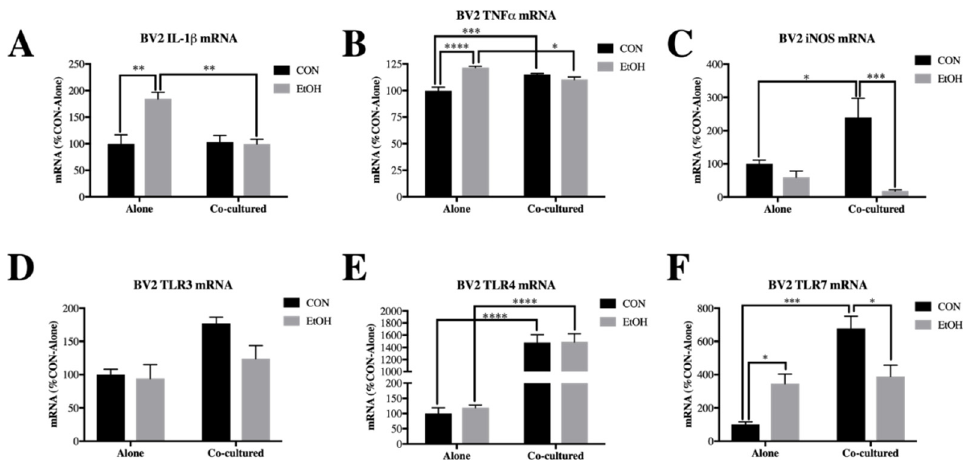
Figure 2. Co-culture alters ethanol-induced cytokines and Toll-like receptors (TLRs) in BV2 microglia. BV2 microglia were treated with ethanol (EtOH, 100 mM) for 24 h either alone or while co-cultured with SH-SY5Y. Cell lysates were examined for mRNA expression. ( A ) IL-1 β expression was increased by EtOH in BV2 alone (185 ± 12%) but not in co-cultured BV2. ( B ) TNF α expression was increased by EtOH in BV2 alone (121 ± 1.2%) and co-culture (115 ± 0.9%) but not by EtOH in co-cultured BV2. ( C ) iNOS was increased by co-culture in BV2 (239 ± 58%), while EtOH significantly reduced iNOS in co-cultured cells (18 ± 4.0%). ( D ) TLR3 expression in BV2. (E ) TLR4 expression was increased by co-culture ( p < 0.0001). ( F ) TLR7 expression was increased by EtOH in BV2 alone (308 ± 59%), as well as by co-culture (678 ± 74%) but was significantly decreased by EtOH in co-cultured BV2 (389 ± 68%). Data is represented as %CON (control)-Alone ± SEM, n = 5–6 wells per group. * p < 0.05, ** p < 0.01,